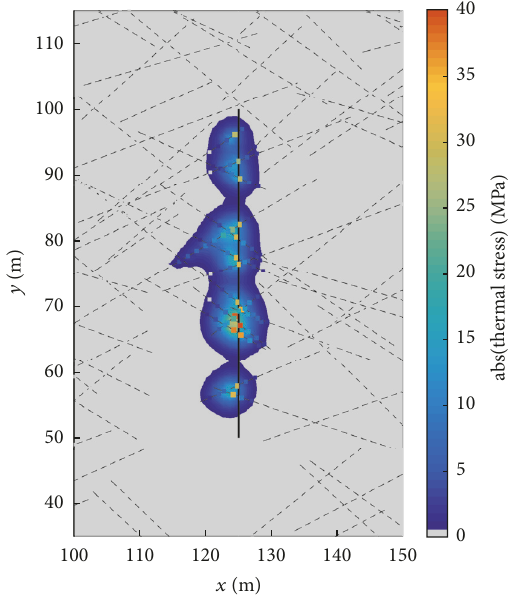
Figure 15: Thermal stress after 30 days of injection into the fracture network. The thermal stress is concentrated close to the injection well. Note that the absolute value of the thermal stress is shown and all thermal stress here is tensional.